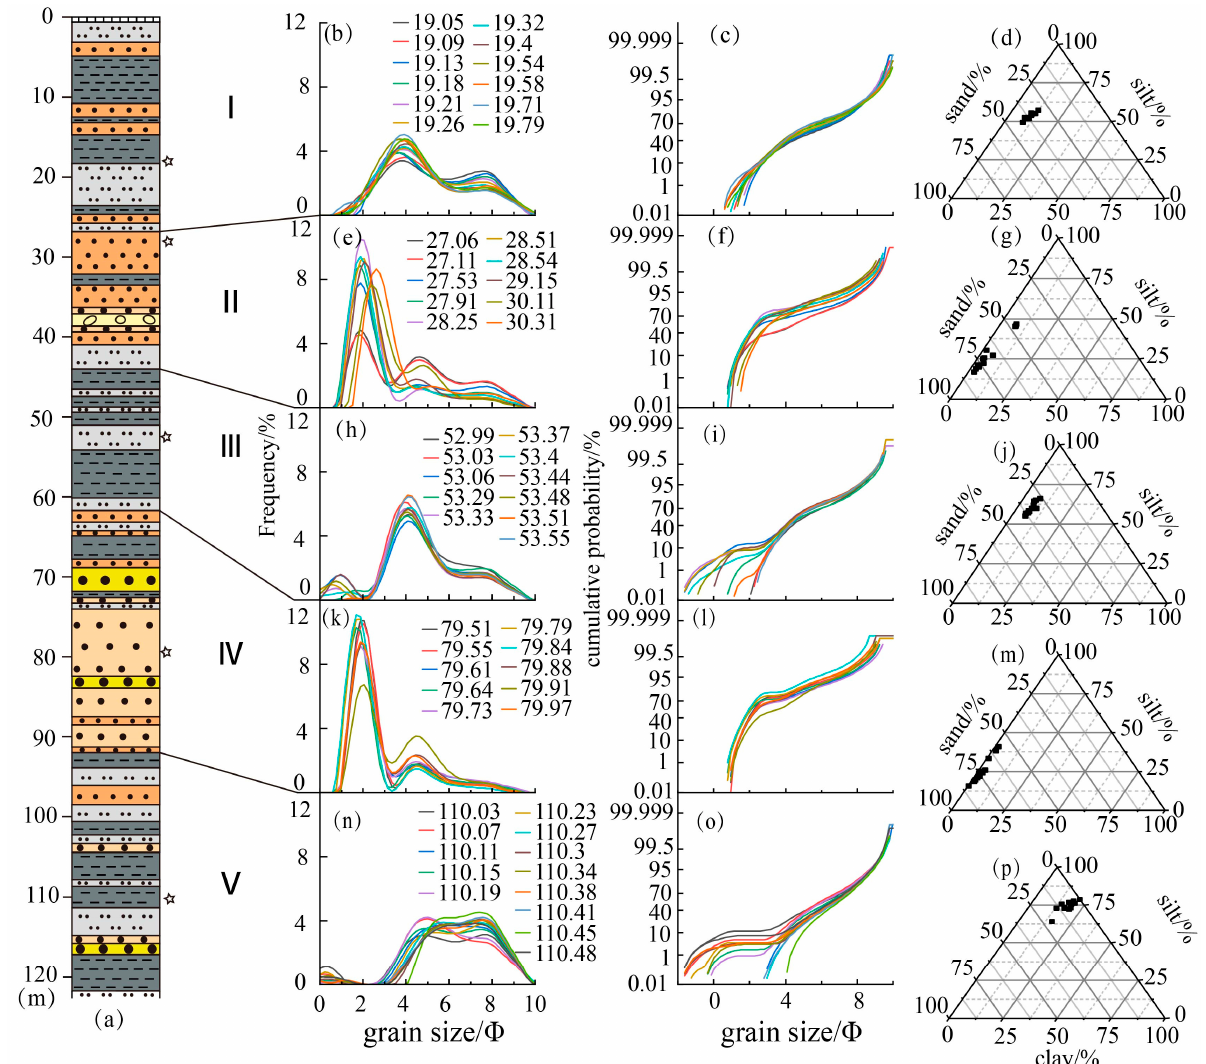
Figure 3. Grain size distribution curves and composition of fi ve di ff erent segments ( ✩ in ( a ) is the grain size analysis samples location). ( a ), Stratigraphic histogram; ( b , e , h , k ), frequency distribution curves; ( c , f , i , l , o ), probability accumulation curves; ( d , g , j , m , p ), grain size composition ( b – d ) are the same sample of the I-segment; ( e – g ) are the same sample of the II-segment; ( h – j ) are the same sample of the III-segment; ( k – m ) are the same sample of the IV-segment; ( n – p ) are the same sample of the V-segment). The III-segment, with a depth from 44.02 m to 61.76 m and an age range between 132.7 ka to 182.1 ka, has similar grain size characteristics (Figures 2b–f and 3h–j) to the I-